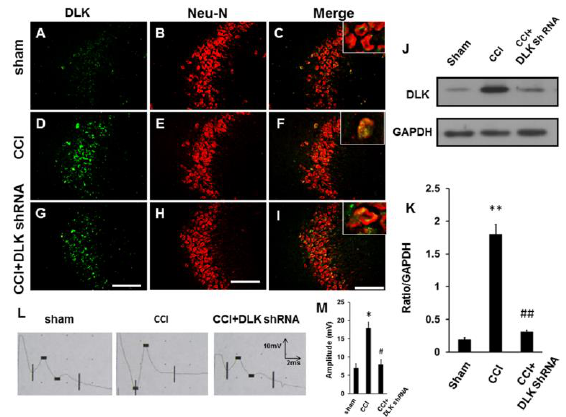
Figure 8. Alteration of DLK expression in the hippocampus and evoked potential subjected to intrathecal injection of DLK shRNA. ( A ) Expression of DLK in the hippocampus in the sham group. ( B ) Co-localization with Neu-N. ( C ) Merged imaging of ( A , B ), right upper box indicated the imaging amplification. ( D ) Expression of DLK in hippocampus in the four rings CCI group. ( E ) Co-localization with Neu-N. ( F ) Merged imaging of ( D , E ), right upper box indicates the imaging amplification. ( G ) Expression of DLK in the hippocampus in the four rings CCI group treated by intrathecal administration of DLK shRNA. ( H ) Co-localization with Neu-N. ( I ) Merged imaging of G and H, right upper box indicates the imaging amplification. ( J ) Illustration of Western blot imaging. ( K ) Quantitative analysis of Western blot analysis. ( L ) Illustration of the amplitude of somatosensory evoked potential in different treated group. ( M ) Quantitative analysis of the amplitude of somatosensory evoked potential in different treatment groups. * p < 0.05, ** p < 0.01 indicated four rings CCI relative to sham; # p < 0.05, ## p < 0.01 indicated the shRNA of DLK relative to four rings CCI group. Bar length = 200 µ